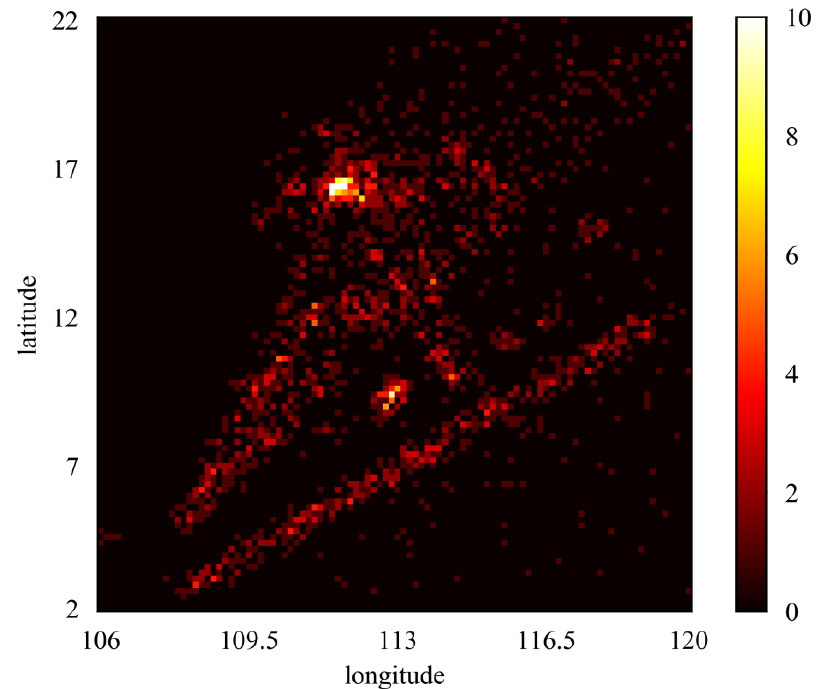
Figure 1. Hot spot map for the traffic accident data sample distributions.